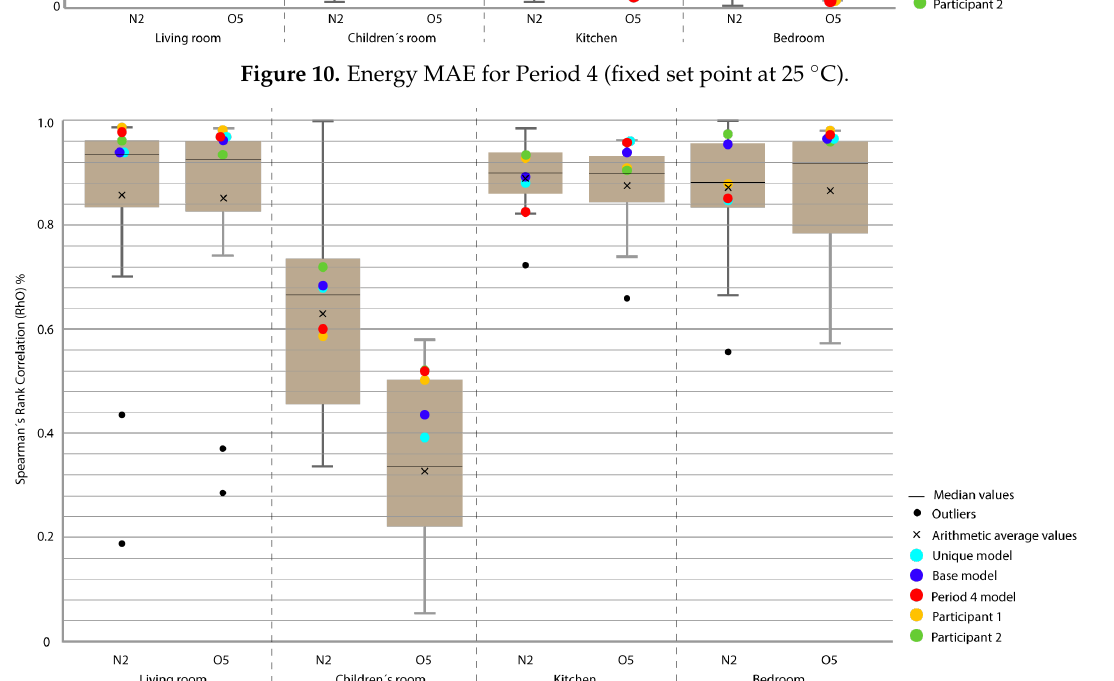
Figure 11. Energy Spearman’s Rank Correlation Coefficient ( ρ ) for Period 4 (fixed set point at 25 ◦ C).